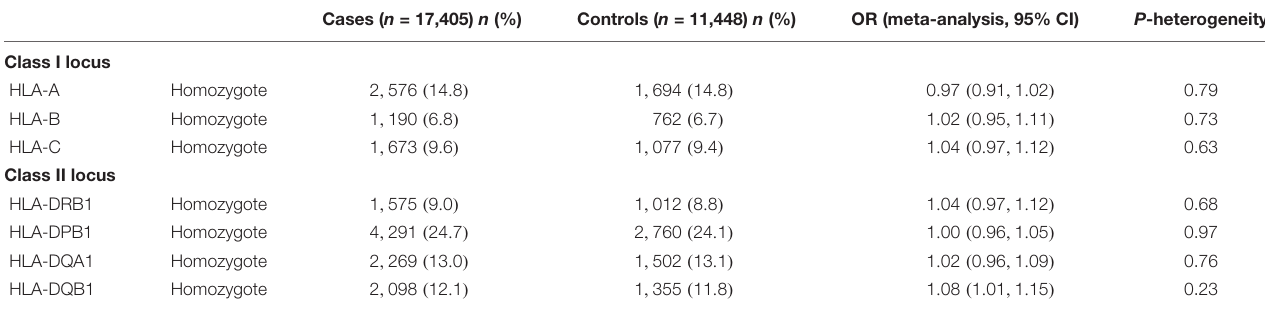
TABLE 2 | Association between homozygosity at HLA class I loci and class II loci and risk of all cancers in Caucasian participants within NCI genome-wide association studies. Cases ( n = 17,405) n (%) Controls ( n = 11,448) n (%) OR (meta-analysis, 95% CI) P